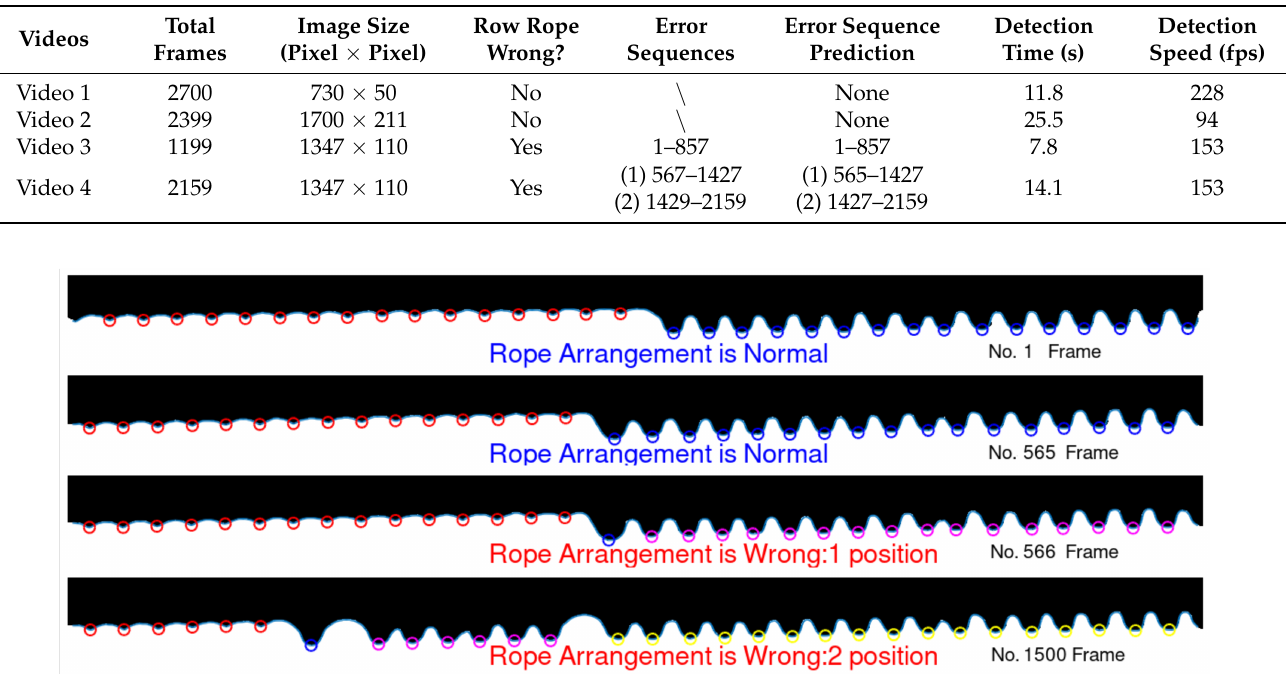
Table 5. The specific parameters of the videos and the results of detection.